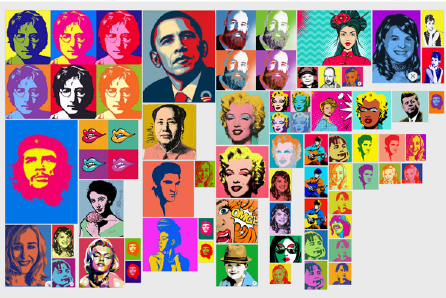
Figure 10. Part of the Pop art style image data set.